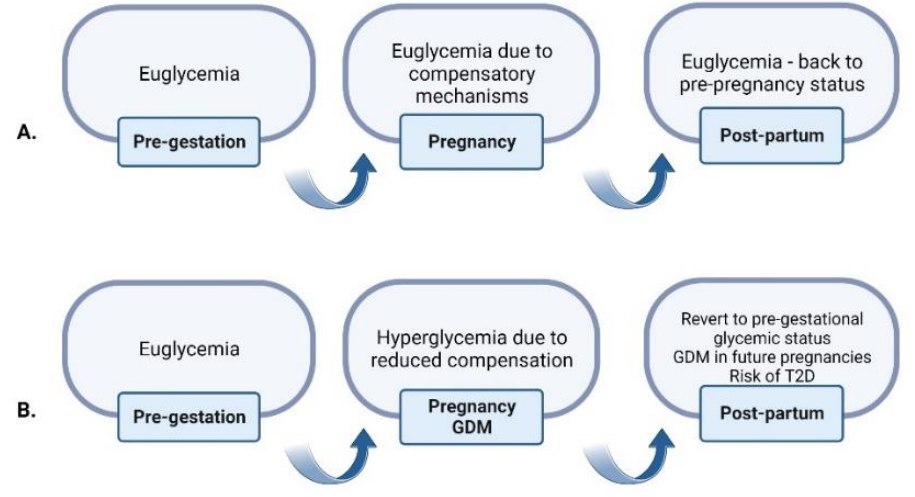
Figure 1. Glycemic status in normal pregnancy versus GDM. ( A ) In a normal pregnancy, the euglycemic status from the pre-gestational period will be preserved by the compensatory mecha- nisms (increasing blood glucose, hyperplasia and hypertrophy of β -cells, decreasing insulin sensi- tivity) which will return to normal after birth. ( B ) In a GDM pregnancy, these mechanisms fail to adapt, resulting in hyperglycemic status. After pregnancy, glycemic status can either return to nor- mal or it can be a risk of T2D and of GDM in future pregnancy [17]. Created with BioRender.com (accessed on 8 October 2022).